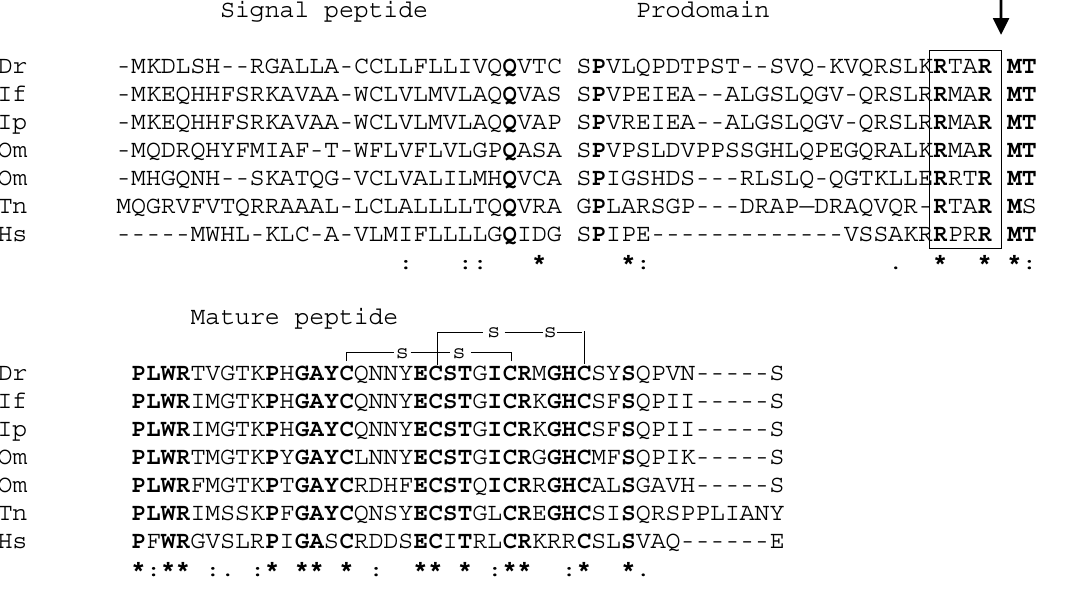
Figure 6. Multiple alignment of zebrafish (Dr, Danio rerio ) liver-expressed antimicrobial peptide 2(LEAP2) protein sequence with known LEAP-2 sequences. The multiple alignment was generated using the Clustal W program (version 1.8) using the LEAP-2 sequences from Ictalurus furcatus (AAX45792), Ictalurus punctatus (AAX45791), Oncorhynchus mykiss (AAS49157, AAR11766), Tetraodon nigroviridis (CAF87882) and Homo sapiens (NP_443203). The arrow indicates the known cleavage site in the human molecule and cleavage motif is boxed. The cysteine bridges are also indicated. Asterisks show identity whilst (.) or (:) indicate